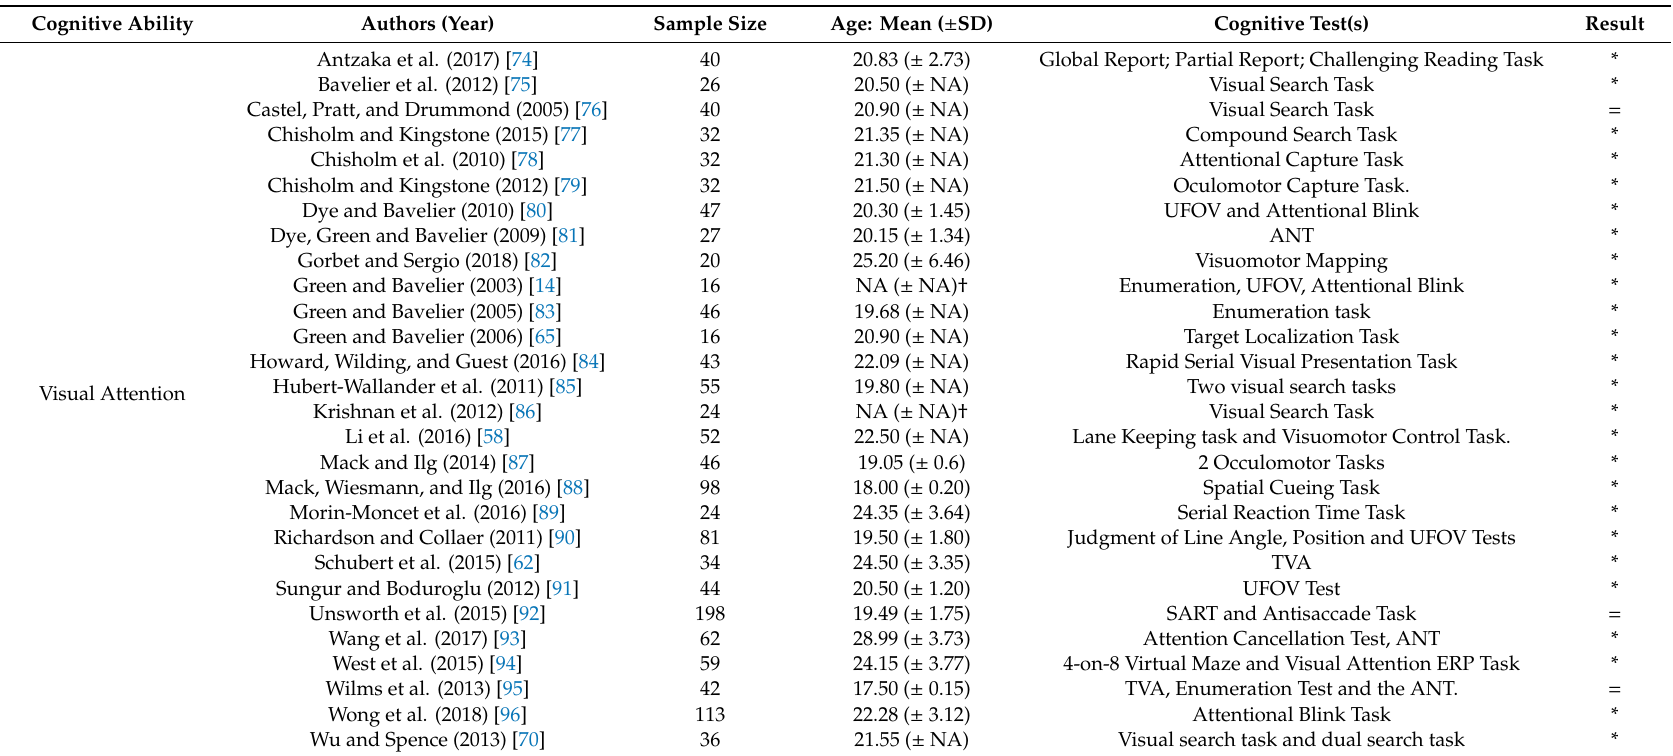
Table 2. Study characteristics for studies comparing the cognitive performance of action video game players (AVGPs) and non gamers (NGs). Articles are organised by the cognitive ability